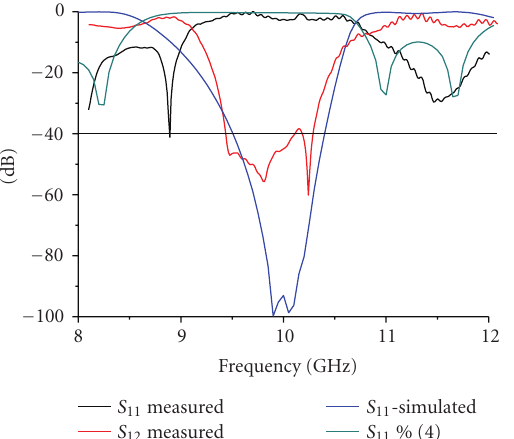
Figure 10: The measured and simulated S-parameters of the Chebyshev filter